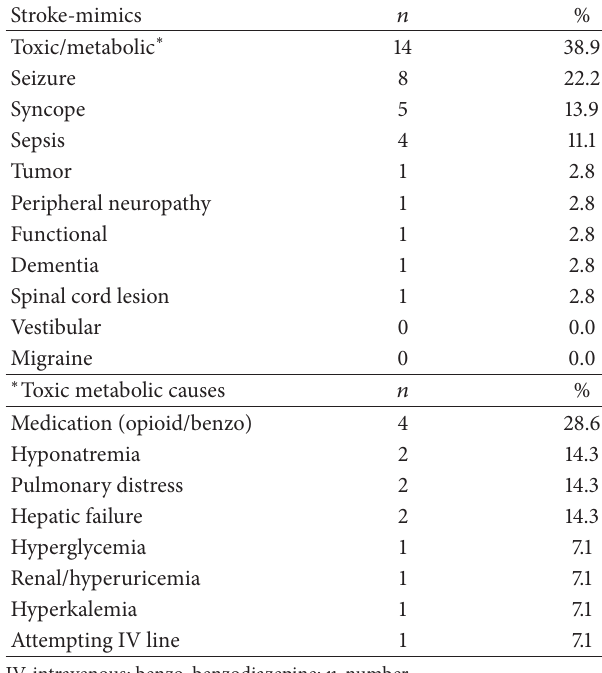
Table 2: Multivariate analysis.